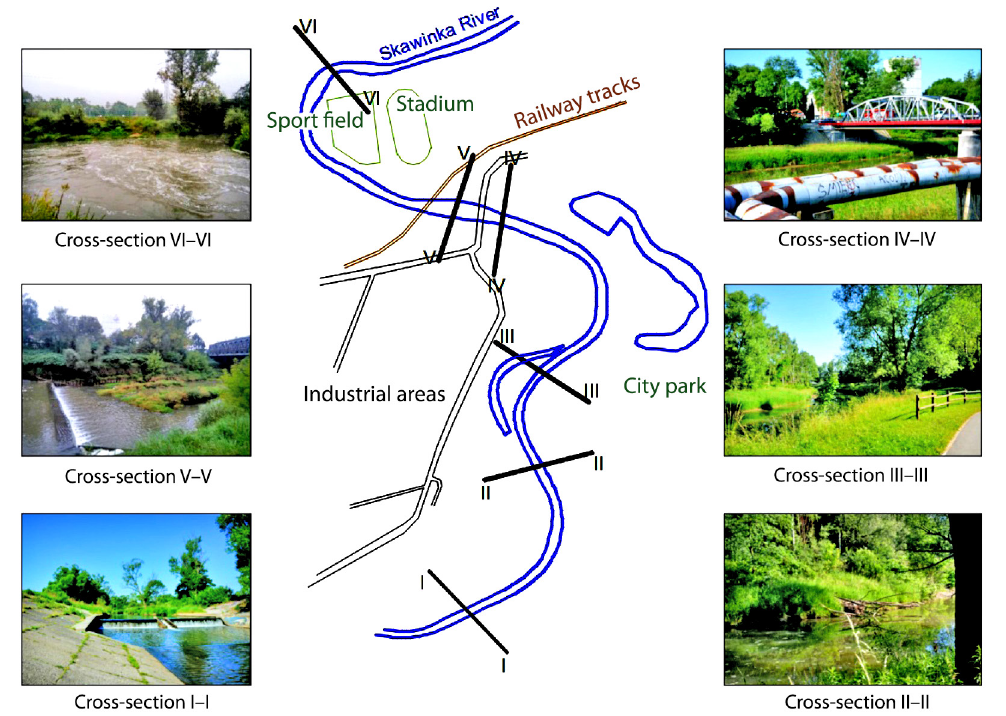
Figure 2. Sections in the study area (drawing and photos from the author’s private